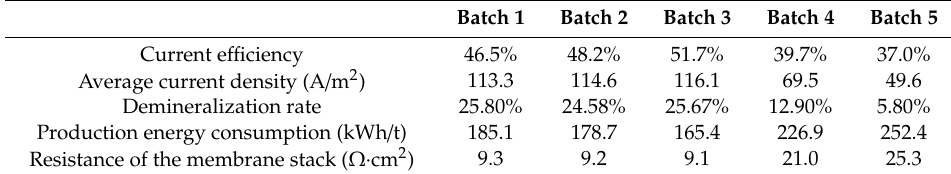
Table 2. Conventional ED performance of sodium gluconate mother liquor.